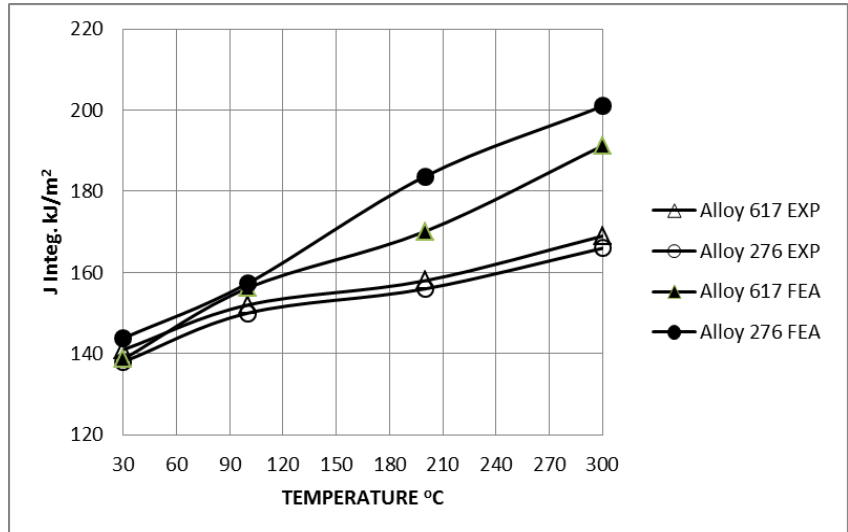
Figure 6: J 1C vs. Temperature